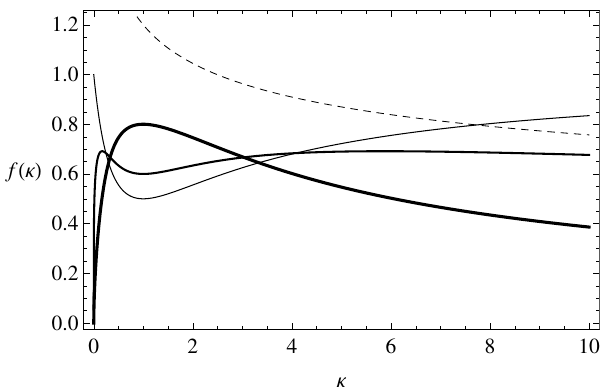
Figure 3 . The distribution f ( (cid:20) ) in eq. (6.14) for m = 1 and some values of (cid:13) : with increasing thickness, (cid:13) = 0 : 5 ; 0 : 6 ; 0 : 8 . The dashed curve is the m = 0 case for (cid:13) = 0 : 6